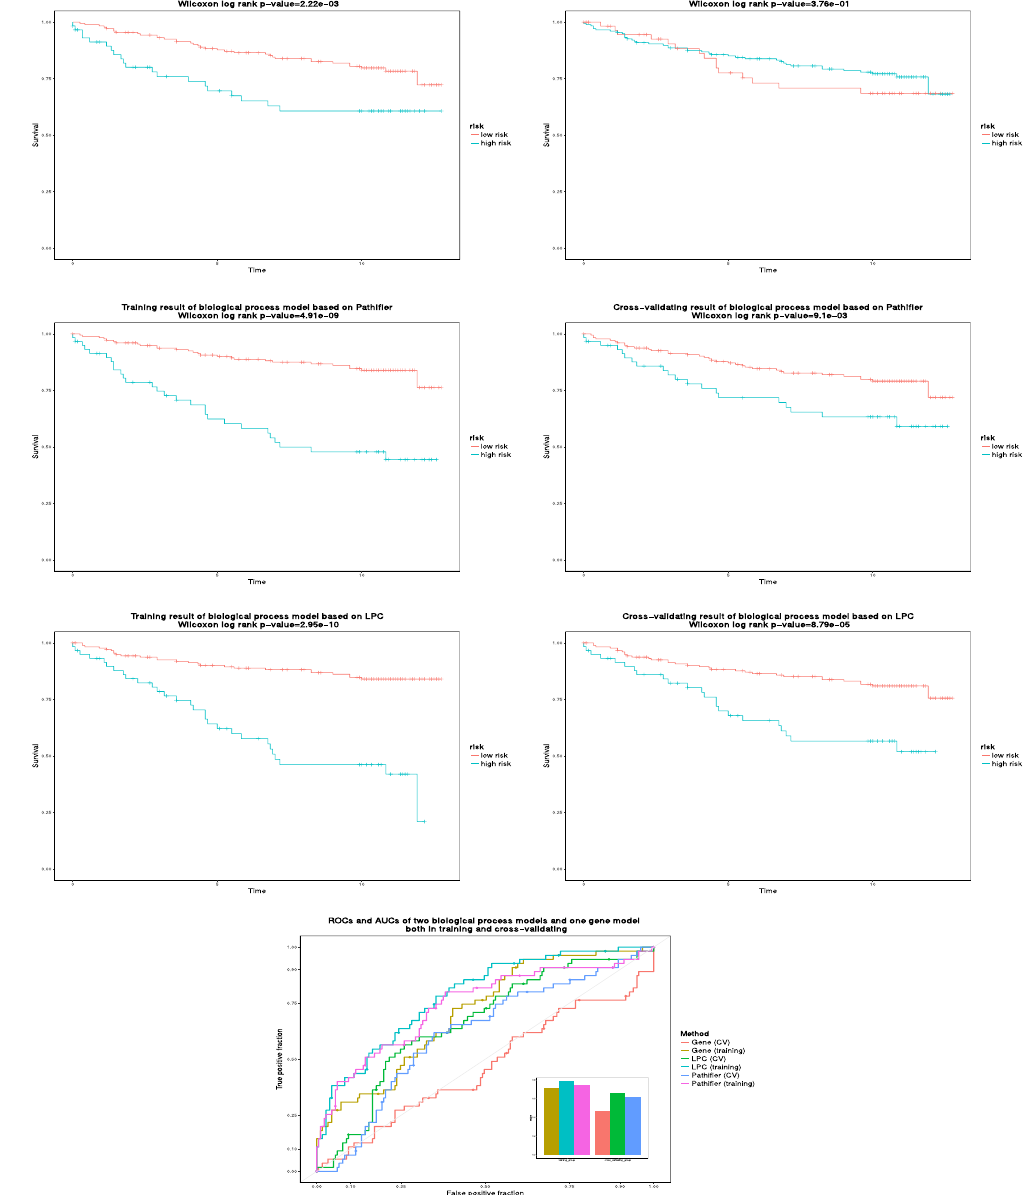
Figure 3. The comparison of the prognosis performance among gene-based model and biological process- based models on GSE3494 dataset. The prognosis indices (PIs) for all samples in the dataset are calculated with associated models, and applied to dichotomize the samples into high and low risk groups in comparison to PI cutoff. The p-values of the survival difference between the two groups are calculated using Wilcoxon log-rank tests, and ( + ) denotes the censored observations. The ROC curves are generated by regarding PI values as predictions in comparison to survival status of samples. Leave one out cross validation (LOOCV) are performed to calculate Wilcoxon log rank p-values and AUCs across models. We found the Wilcoxon log rank p-values and the AUCs derived from the model based on BPS matrix yielded by LPC outperform than those derived from the models based on PAM50 gene expression matrix and PDS matrix yielded by Pathifier both in training and cross validating